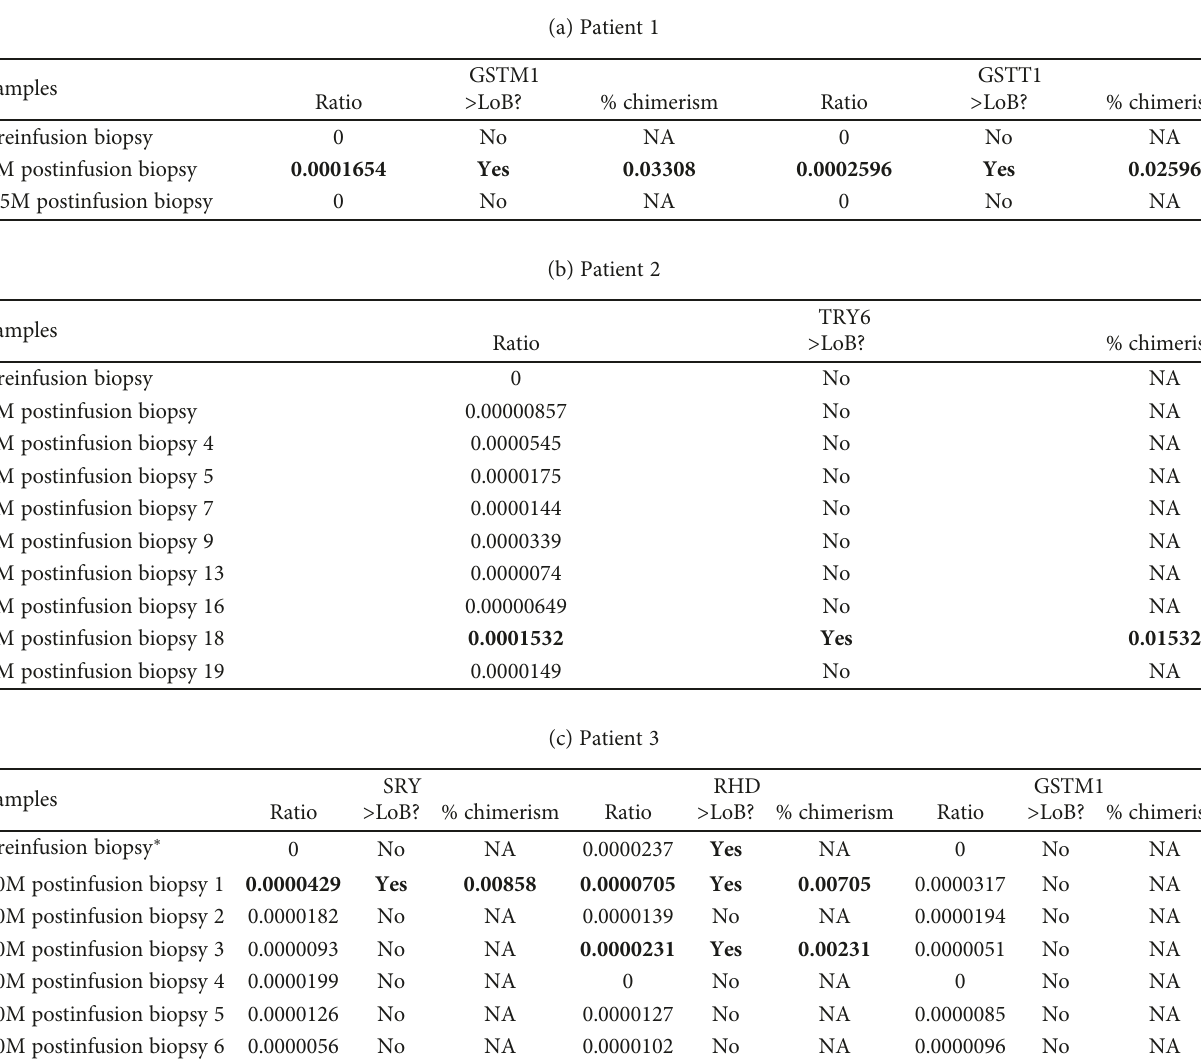
Table 7: Percentage of microchimerism detected in patients ’ biopsies. LoB: limit of